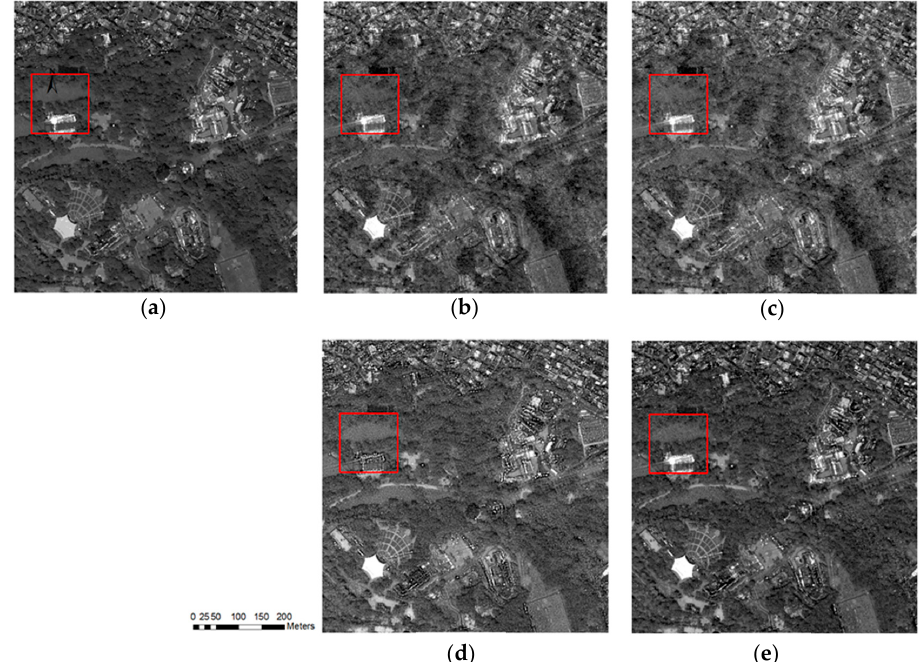
Figure 6. Comparison with the results of image fusion for Site 1: ( a ) proposed method; ( b ) a-trous wavelet decomposition; ( c ) discrete wavelet transform; ( d ) non-subsampled contourlet transform; and ( e ) non-subsampled contourlet transform-pulse couple neural network.